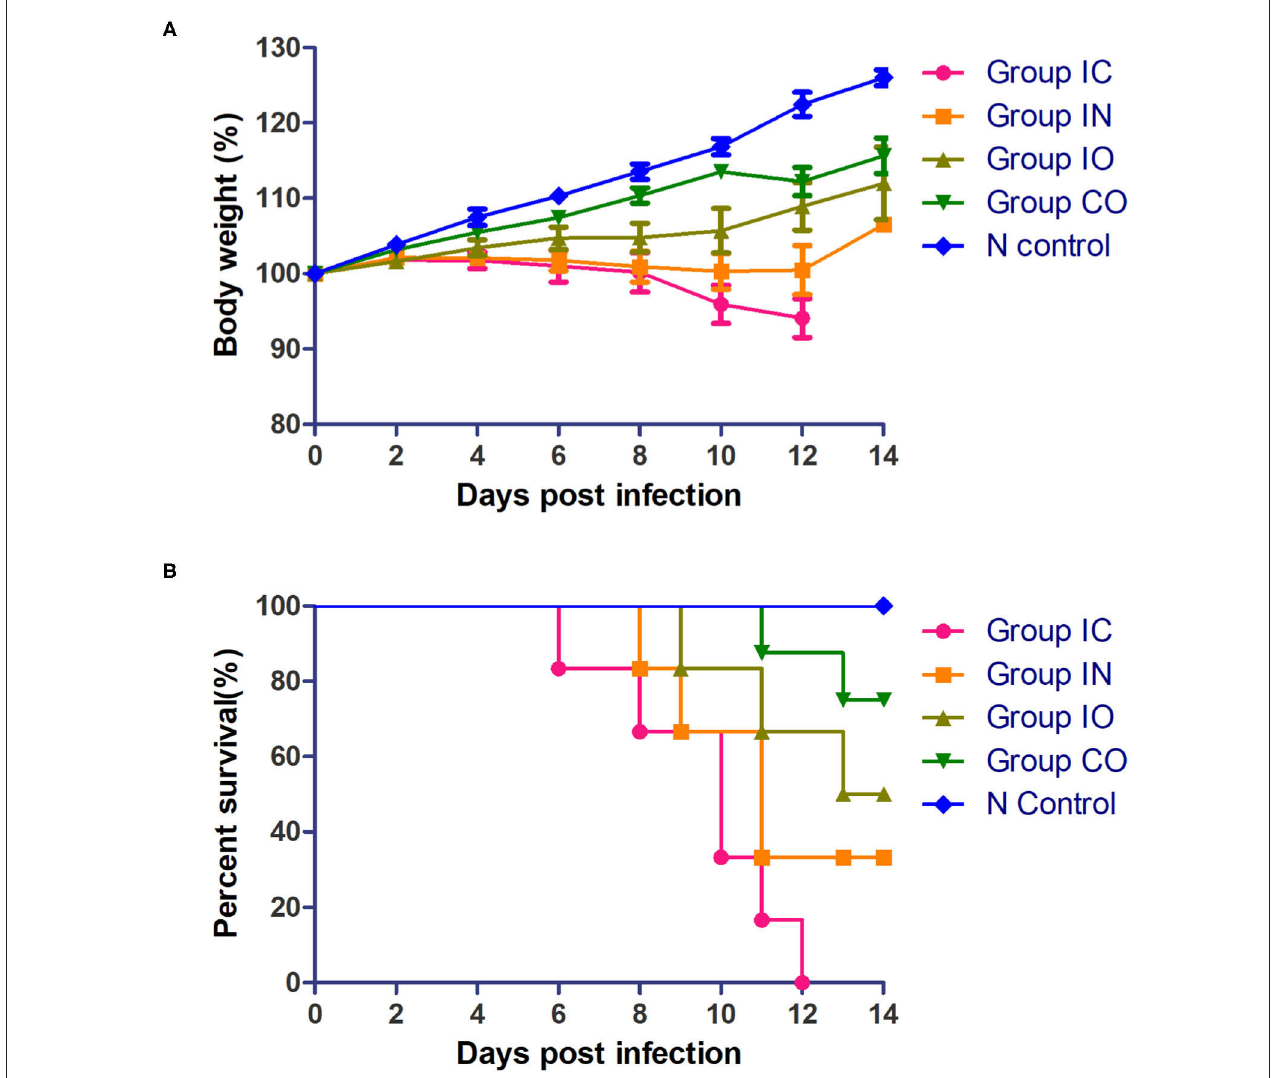
FIGURE 2 | Pathogenicity of the PPMV-1/BJ-01/CH in different routes of infection. (A) Body weight change of different groups post-infection. (B) Survival curve of different groups